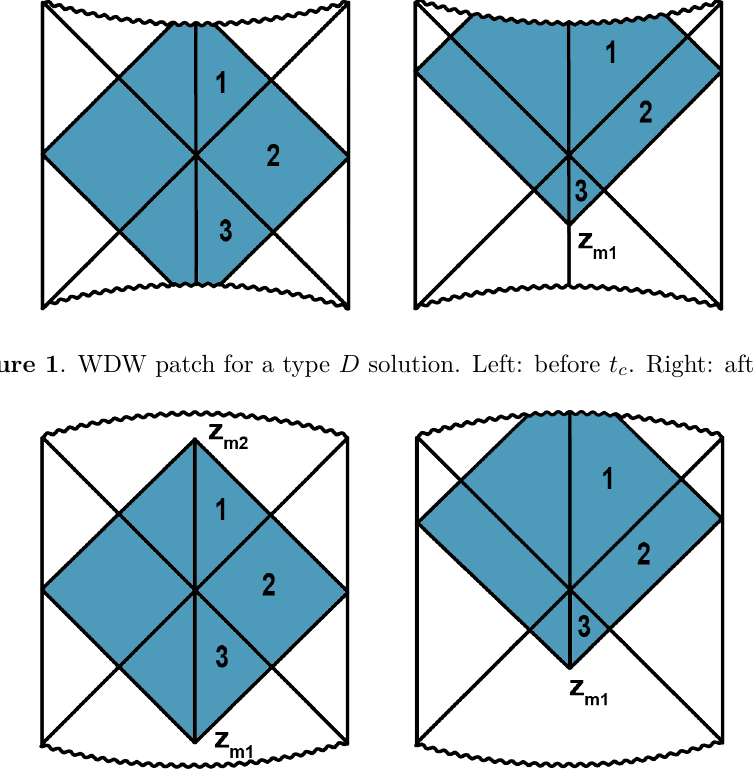
Figure 2 . WDW patch for type U . Left: before t c . Right: after t c